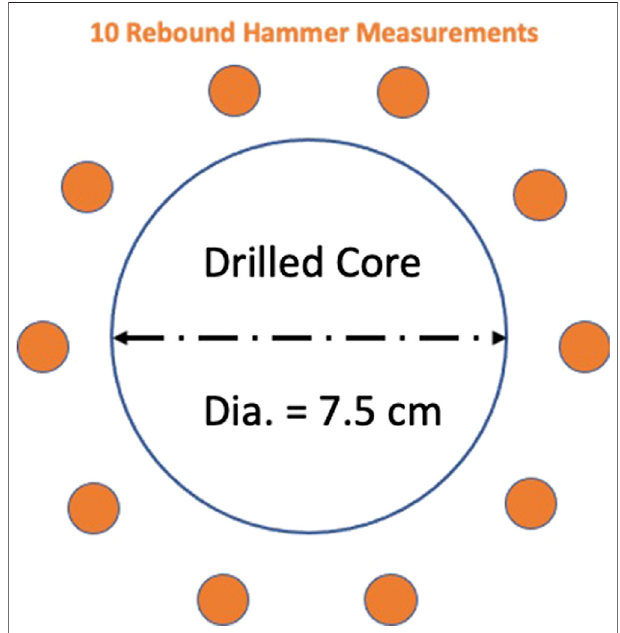
FIGURE 6 | Rebound hammer and core sample location.